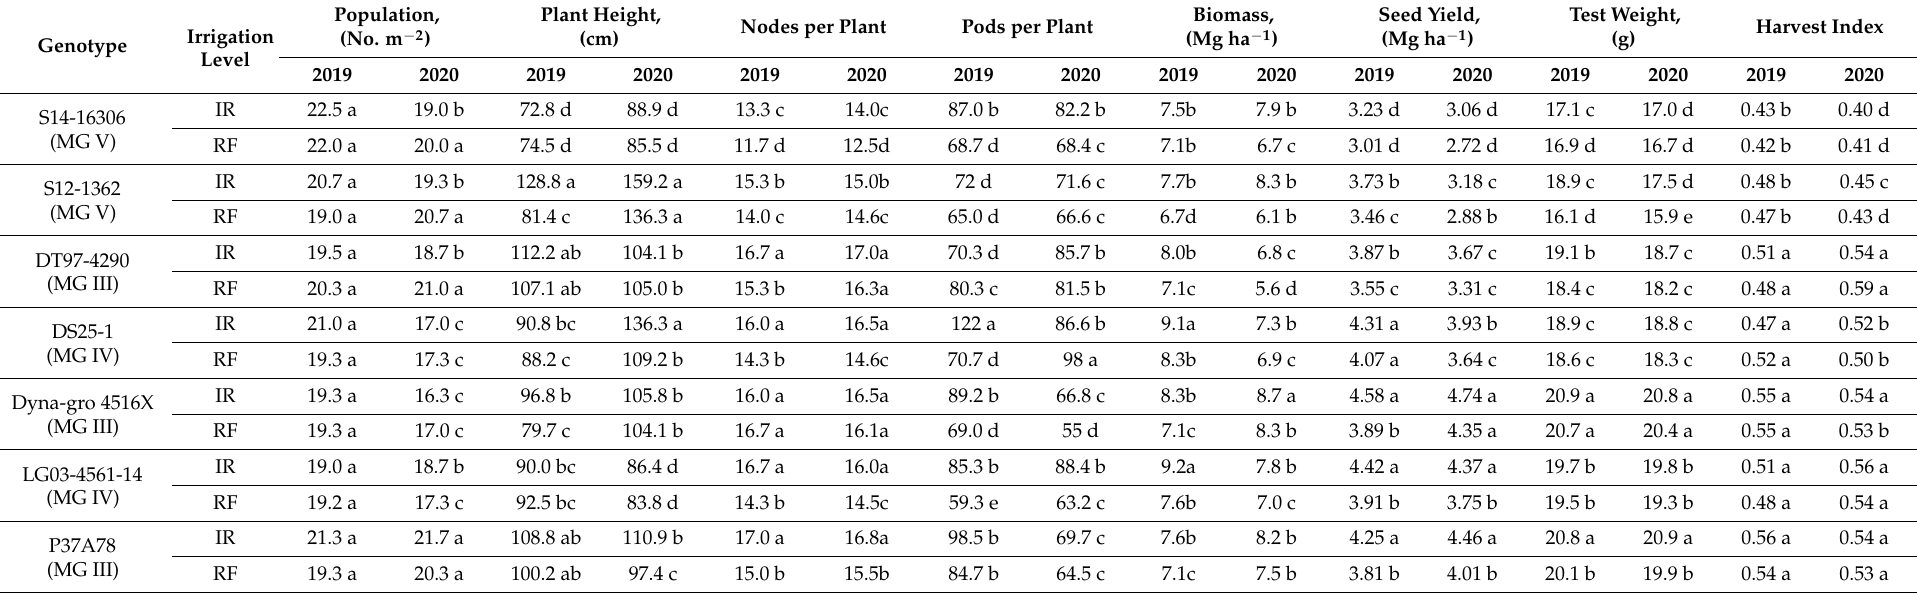
Table 5. Soybean cultivar population, above ground biomass, grain yield components, plant height, and harvest index grown in Dundee silt loam under irrigated (IR) and rainfed (RF)